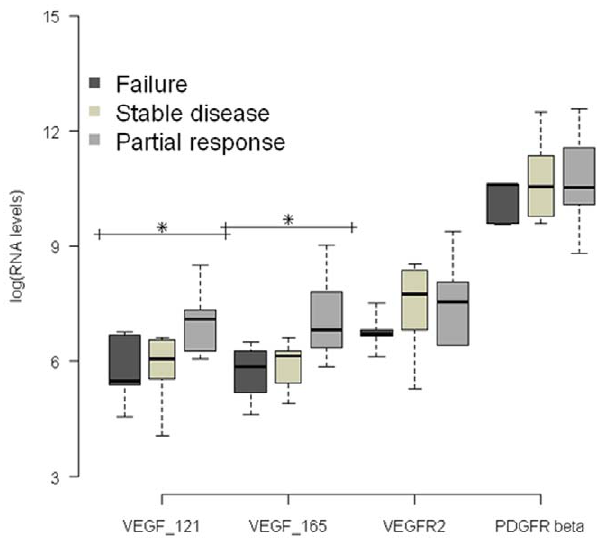
Figure 1. Boxplot of four RNA expression levels (in log 10 scale) according to treatment response. The expression levels of interesting transcripts were normalized to the housekeeping PPIA (peptidylprolyl isomerase A) and TBP (TATA-box binding protein) gene transcripts. Since there was no difference between control genes, results were presented as copies of target gene per copy of PPIA. The median values and their corresponding logarithmic values in brackets were respectively: for VEGF 121 PR 1222 (7.1), SD 425 (6.0) and Failure 241 (5.4); and for VEGF 165 PR 905 (6.8), SD 460 (6.1) and Failure 352 (5.8). (*) for p ,